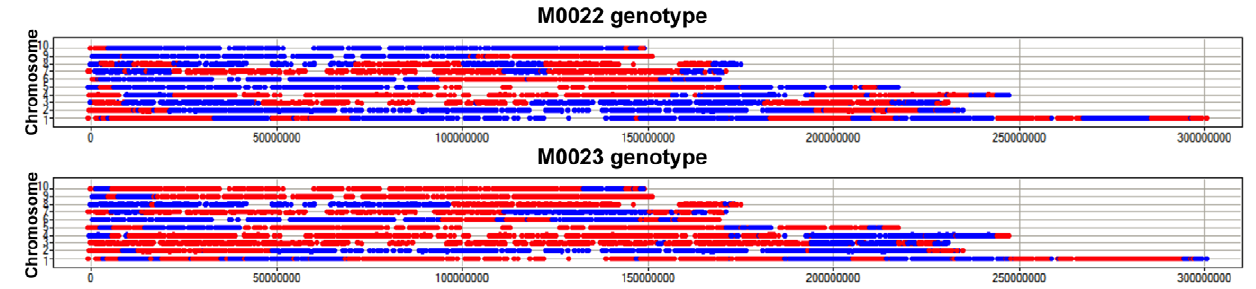
Figure 2. Visualization of whole genome genotypes of two RILs. The genotype of each BAC with at least 5 filtered B . M probes (n=7,978 that were called in both lines) was determined and color coded (B73 – blue; Mo17 – red). BACs were then plotted according to their physical positions along a chromosome (x-axis) and by chromosome (y-axis). This visualization was created using a single replicate of data.